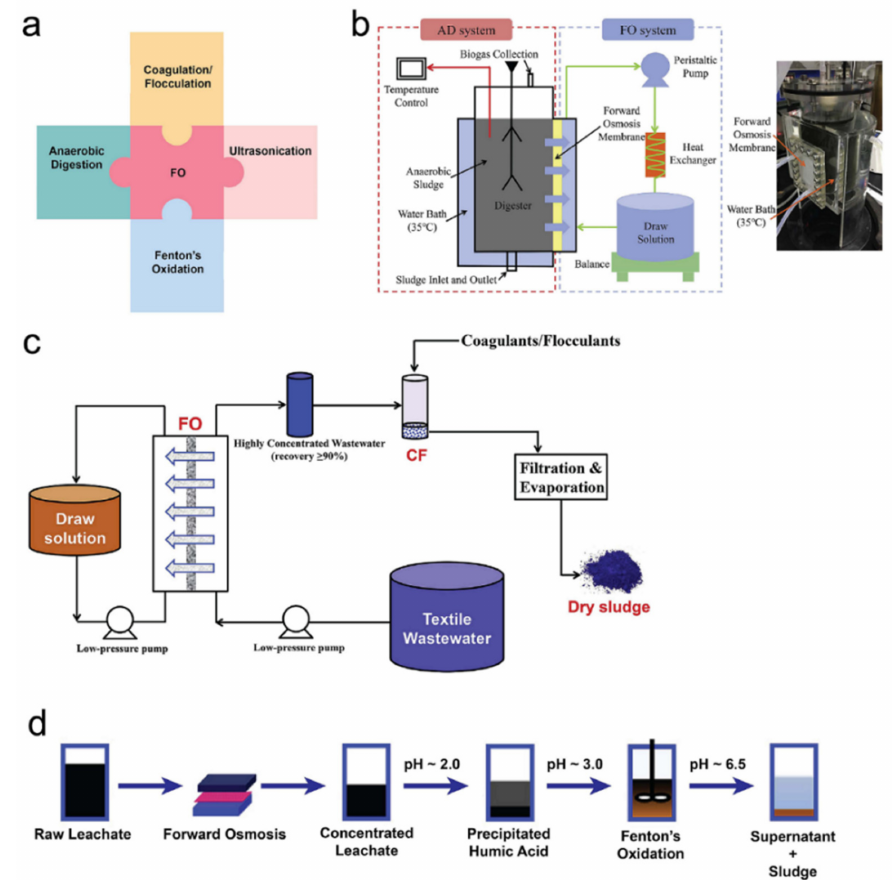
Figure 7. ( a ) Illustration of the integration of FO with other water treatment technologies, ( b ) the hybrid FO-AD system, reprinted with permission from [105], ( c ) the hybrid FO-CF system, reprinted with permission from [113], and ( d ) the integration of FO with Fenton’s oxidation, adapted from